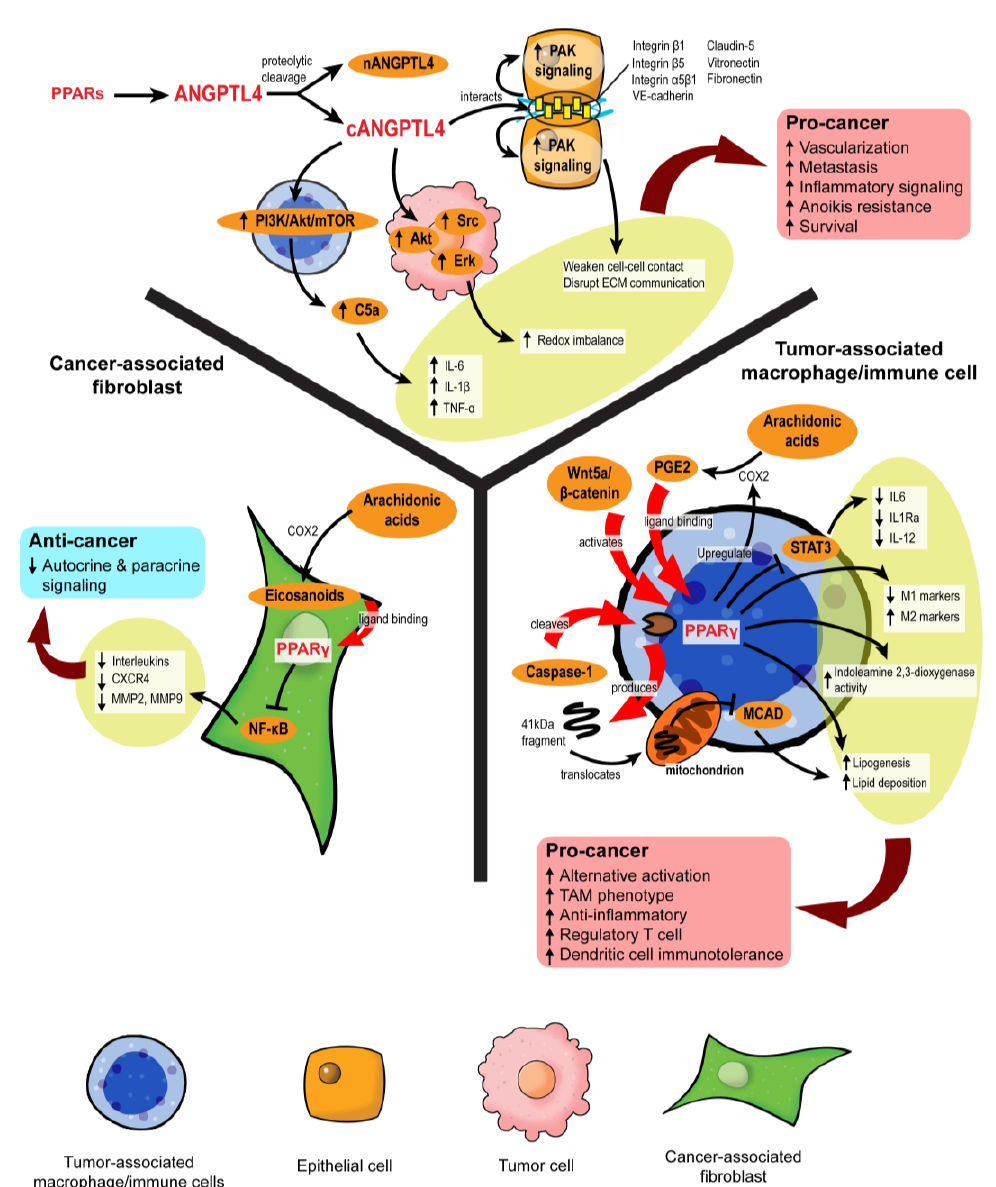
Figure 5. PPARs modulate stromal–epithelial crosstalk in the tumor microenvironment. PPARs affect autocrine and paracrine signaling in different stromal cells. In cancer-associated fibroblasts, PPAR γ activation upon ligand binding represses NF- κ B, alleviating the secretion of many autocrine and paracrine signals. However, in macrophages and immune cells, PPAR γ activation is primarily linked to pro-cancer activities, such as the formation of tumor-associated macrophages (TAMs), increased regulatory T cells, and immunotolerance. ANGPTL4 is a target gene product of PPARs. Proteolytic cleavage of full-length ANGPTL4 yields nANGPTL4 and cANGPTL4 domains, of which the latter is a potent paracrine signal and key mediator of inflammatory signals, anoikis resistance, and